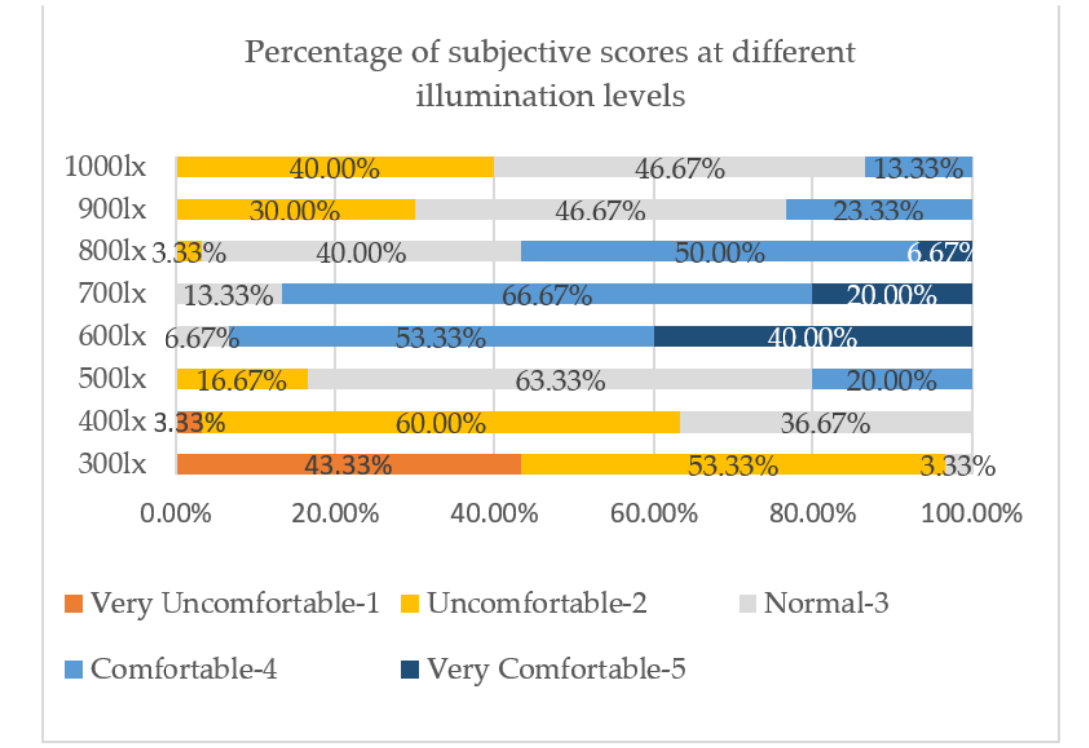
Figure 11. Percentage of subjective scores at different illumination levels. Table 9. Average value of the visual comfort